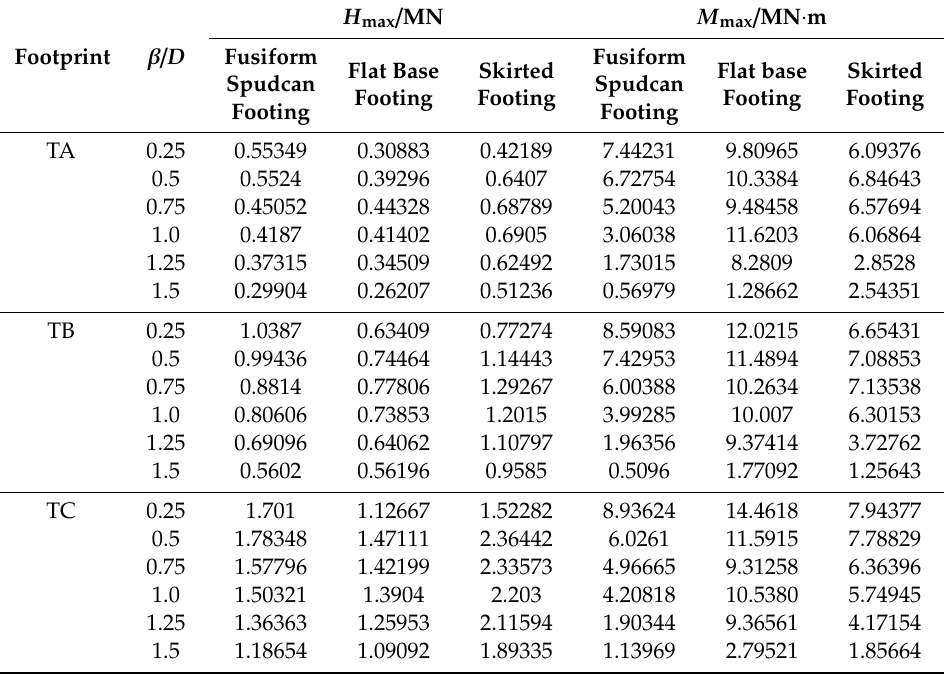
Table A1. The list of peak